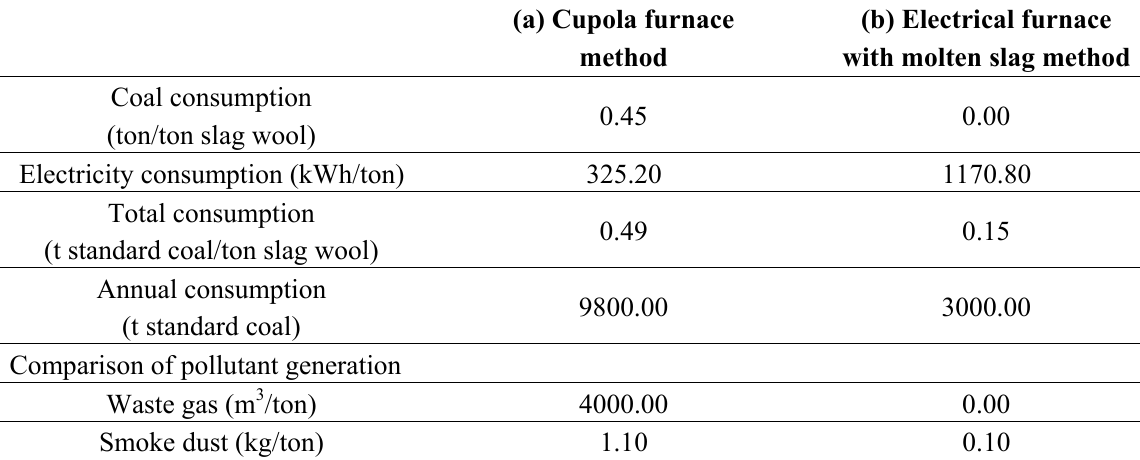
Table 3. Comparison of energy consumption and pollutant